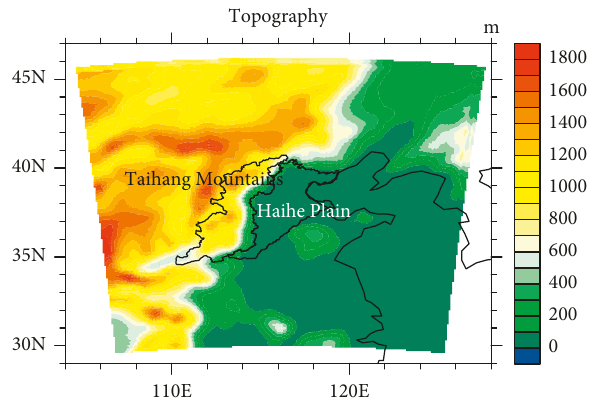
Figure 1: Topography of the simulation domain. The Taihang Mountains and Haihe Plain are outlined in